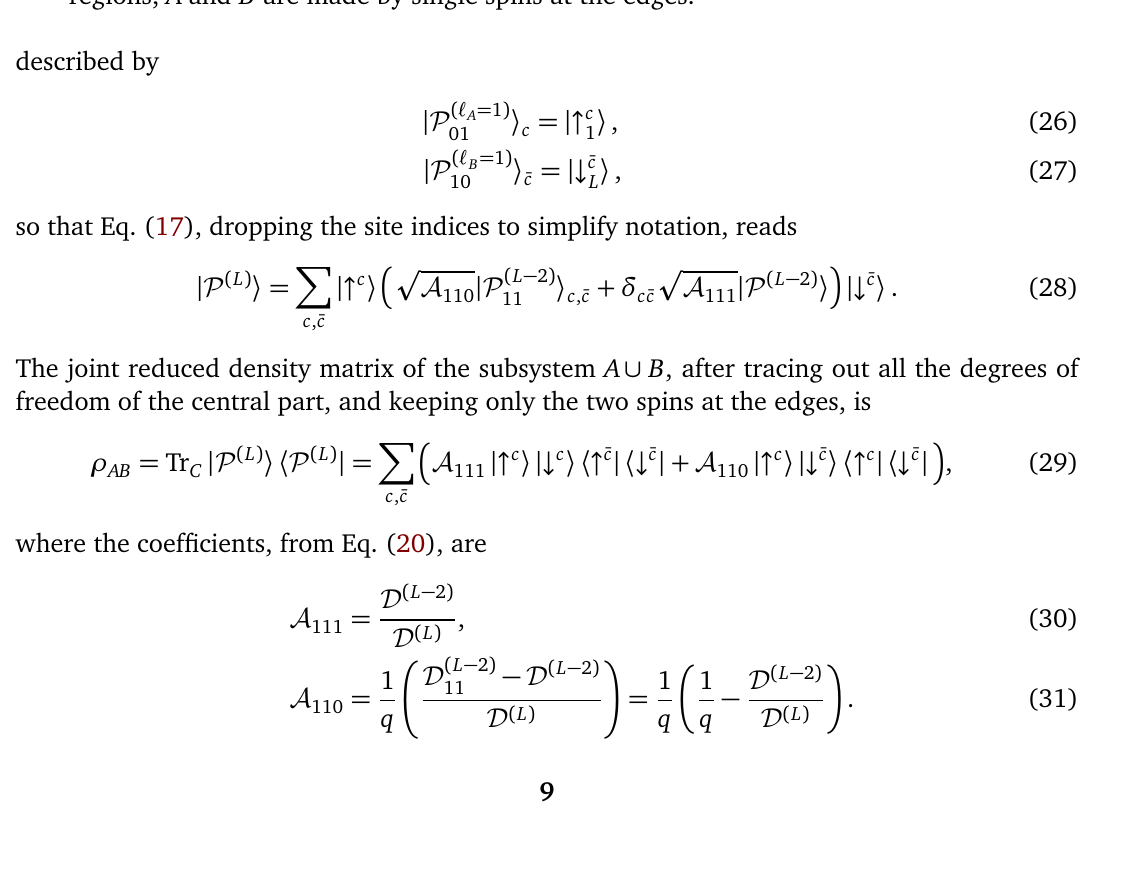
Figure 4: Tripartition of a spin chain in three subsystems A , B , C , where the separated regions, A and B are made by single spins at the